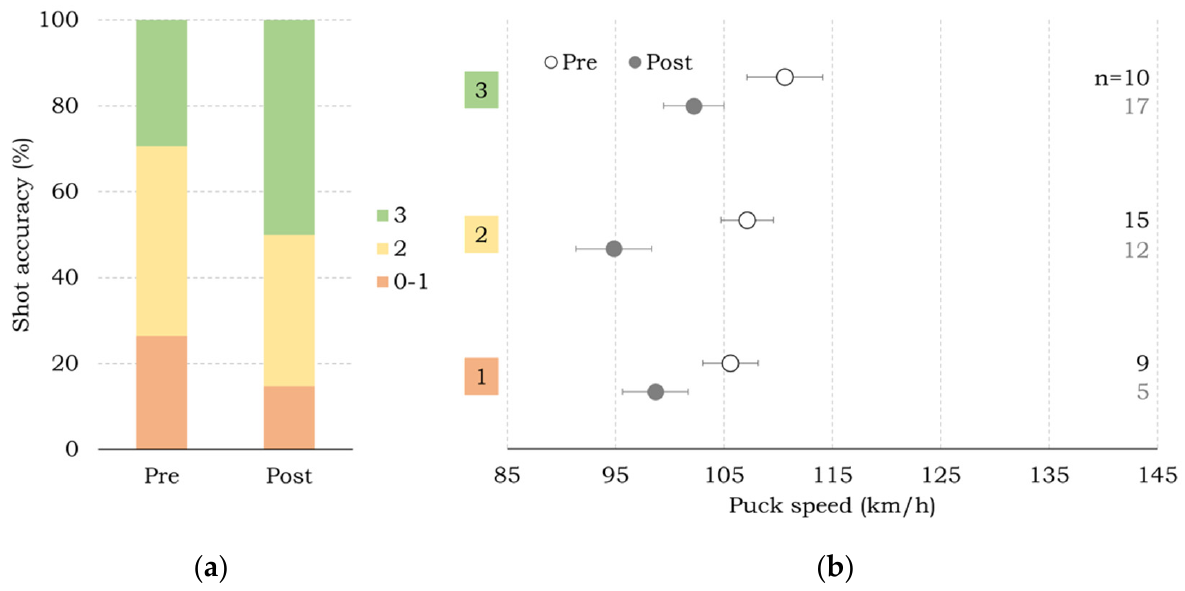
Figure 2. Wrist shot accuracy and associated puck speed on three attempts before (Pre) and after (Post) the IHCT: ( a ) Relative occurrence of successful goal shots; ( b ) Puck speed with the number of athletes within the respective subgroup. Values are mean with 90% confidence intervals.